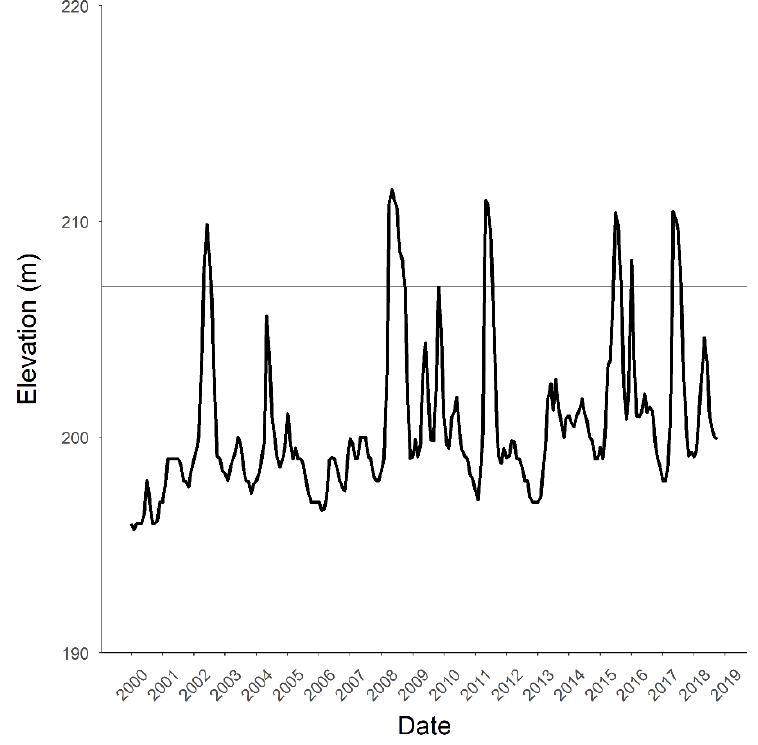
Figure 2. Elevation of Bull Shoals Reservoir from January 2000–October 2018 (coinciding with our biological surveys). One invasion hypothesis is that the reservoir elevation facilitates movement of gapped ringed crayfish Faxonius neglectus chaenodactylus into Tumbling Creek Cave. Several of the springs that drain to the cave are inundated when the reservoir elevation reaches 204–207 m (shown by line).